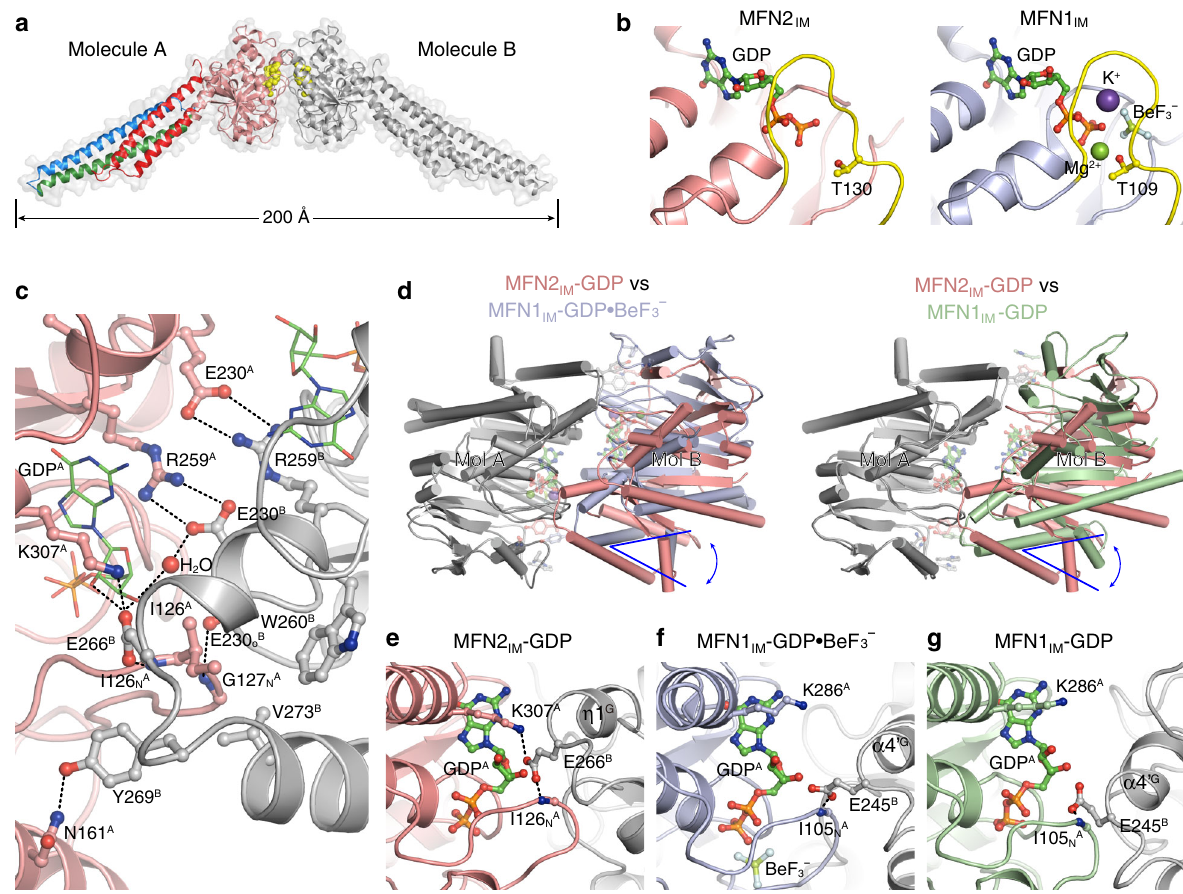
Fig. 3 Dimerization of MFN2 IM via the G domain. a The MFN2 IM dimer in GDP-bound state, with transparent surface representation. Molecule A is colored as in Fig. 1b, molecule B is in gray. GDP is shown as yellow spheres. b , Switch I con fi guration of MFN2 IM -GDP structure and MFN1 IM (Protein Data Bank code 5YEW) in the transition state. Switch I is colored yellow. The catalytic residues MFN2 IM (Thr130) and MFN1 IM (Thr109) are shown as ball-and-stick models. c Details of the G interface of MFN2 IM . Only one side of the G interface is shown for other involved residues except for the central dual salt bridges. d Structural comparison of MFN2 IM -GDP dimer with MFN1 IM - GDP (cid:1) BeF (cid:3) dimer (PDB code 5YEW, left) and with MFN1 IM -GDP dimer (PDB code 3 5GOM, right). The structures are superimposed for one polypeptide chain (Mol A, shown in gray). The positions of the other chain (Mol B) showed a clear difference in orientation between MFN2 IM (pink) and MFN1 IM structures (light blue or green). Comparison of the G interface of MFN2 IM in the GDP-bound state ( e ) between MFN1 IM in the transition state ( f PDB code 5YEW) and in the GDP-bound state ( g PDB code 5GOM). Note the MFN2-speci fi c